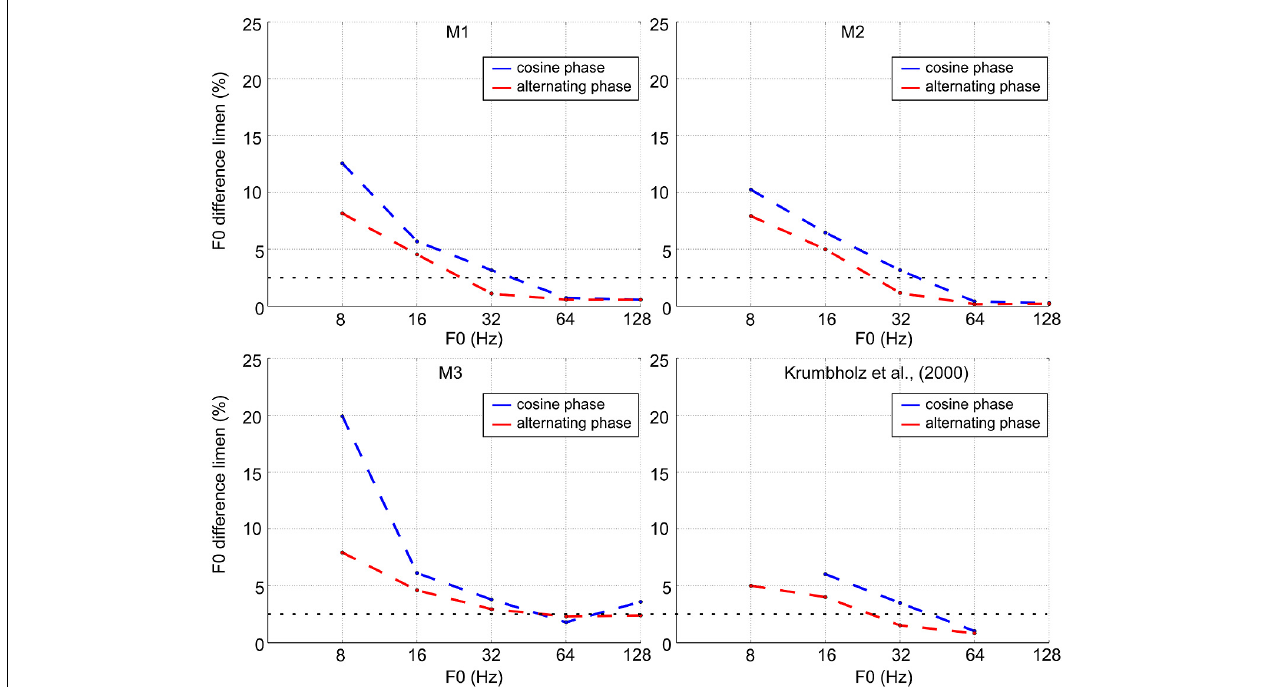
FIGURE 3 | F0 discrimination threshold as a function of F0 for cosine-phase and alternating-phase tones for the three macaques and a comparison set of average thresholds for humans (adapted from Krumbholz etal., 2000).